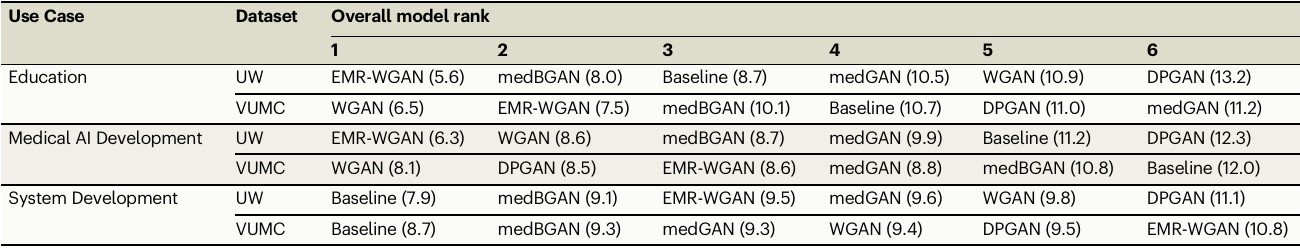
Table 4 | Overall rank of generative models for the use cases in the Model recommendation phase Use Case